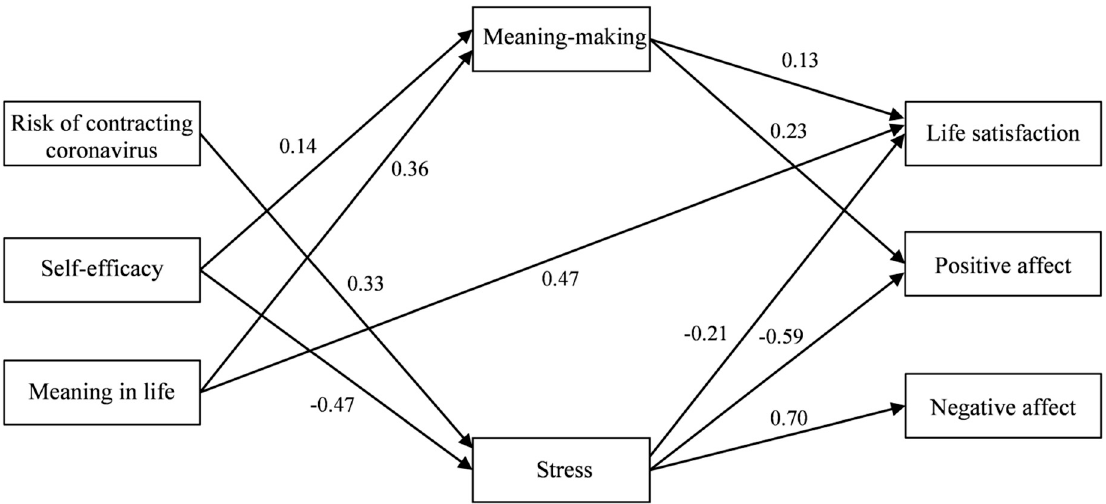
Figure 2. Final model of the relations between risk of contracting COVID-19, self-efficacy, meaning in life, meaning-making, stress and the dimensions of subjective well-being (all standardized coefficients are significant).